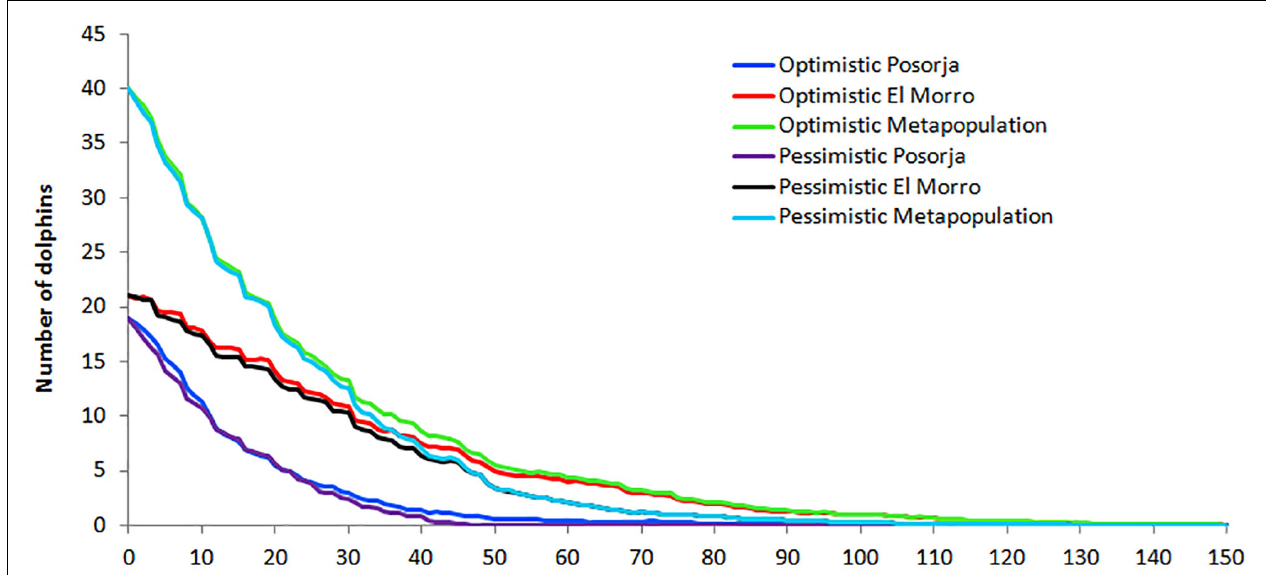
FIGURE 10 | Population trajectories modeled under optimistic and pessimistic sceneries for the Posorja, El Morro and both communities as a metapopulation. Models extended to 150 years into the future, consensus for 100